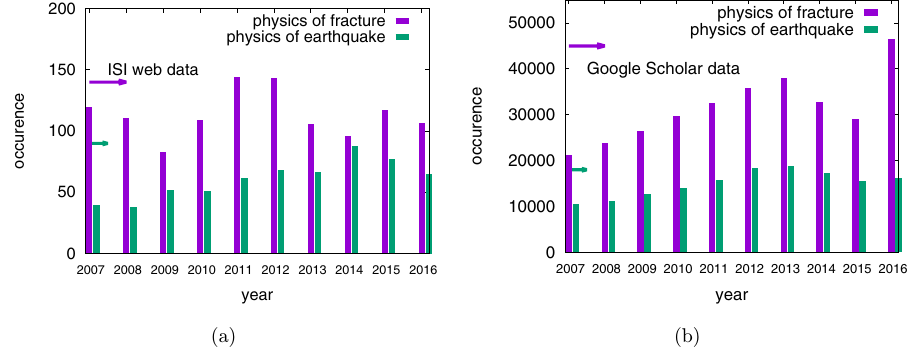
Fig. 3. (a) The number of papers on physics of fracture and earthquakes listed in ISI Web of Science; (b) The same is shown for the Google Scholar data.